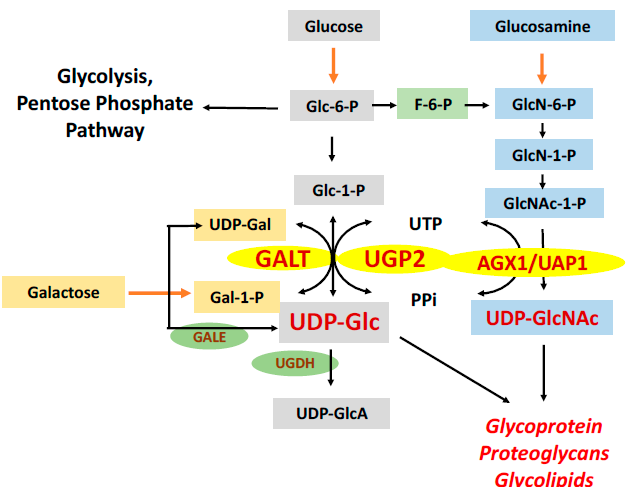
Figure 1. Roles of UDP-hexose pyrophosphorylases in glycan biosynthesis. Schematic representation of the roles played by the three known UDP-hexose pyrophosphorylases in the glucose (Glc) metabolic and the hexosamine biosynthetic pathways. (GALK1: galactokinase, GALT: galactose-1 phosphate-uridylyltransferase, UGP2: UDP-glucose pyrophosphorylase, UGDH: UDP-glucose 6-dehydrogenase, GALE: UDP-glucose-4-epimerase, AGX1 / UAP1: UDP- N -acetylglucosamine pyrophosphorylase).